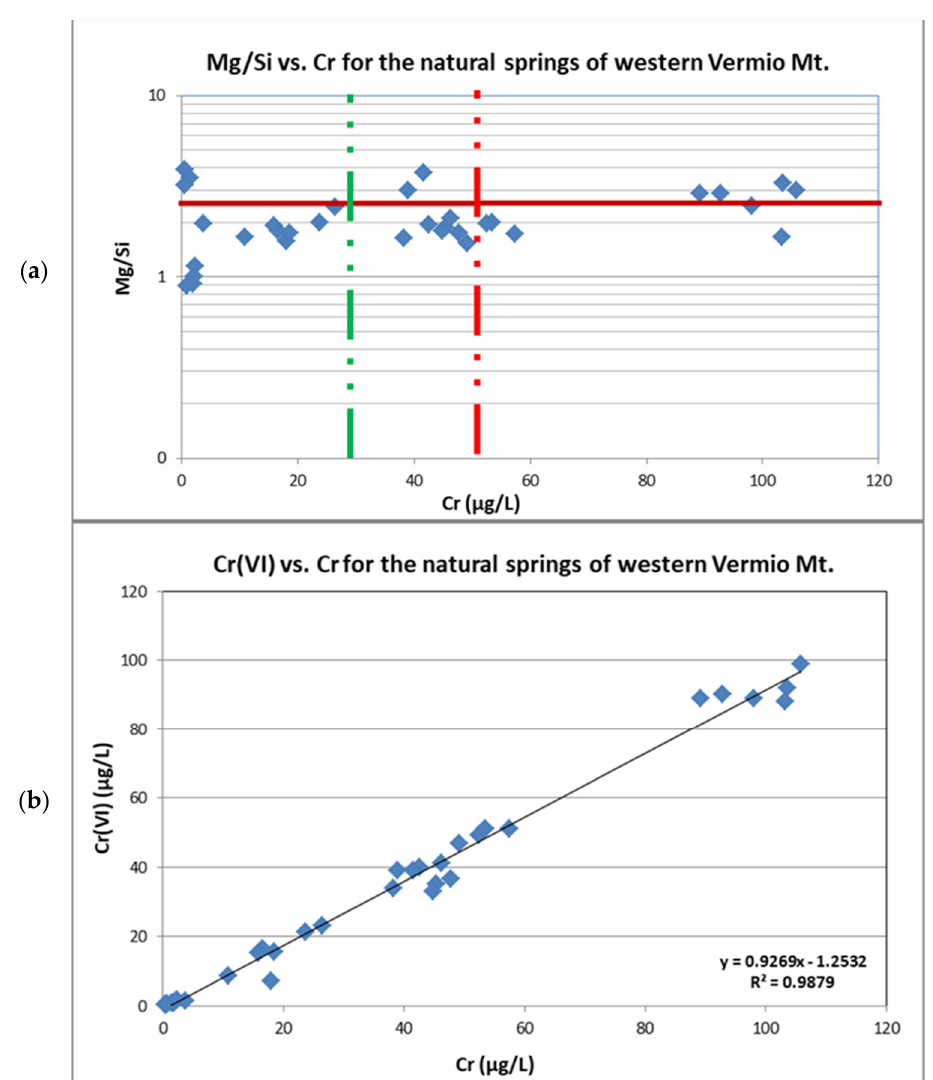
Figure 18. Plots of: ( a ) Mg/Si vs. Cr and ( b ) Cr(VI) vs. Cr (regression model) of the natural springs in western Vermio